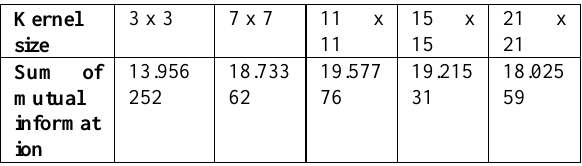
Table 2. Sum of mutual information feature score for 5 different kernel sizes.